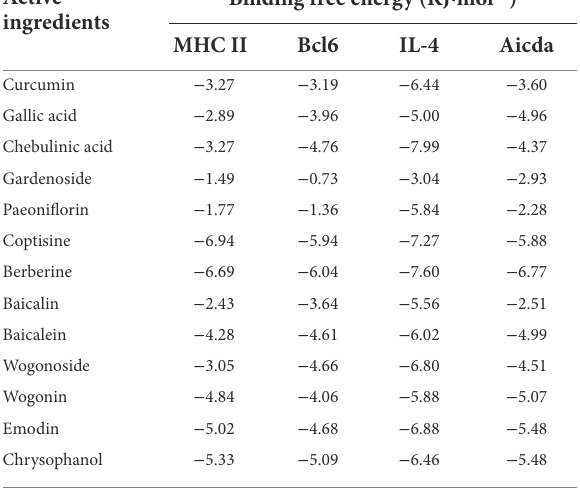
TABLE 2 Molecular docking free energy. Active ingredients